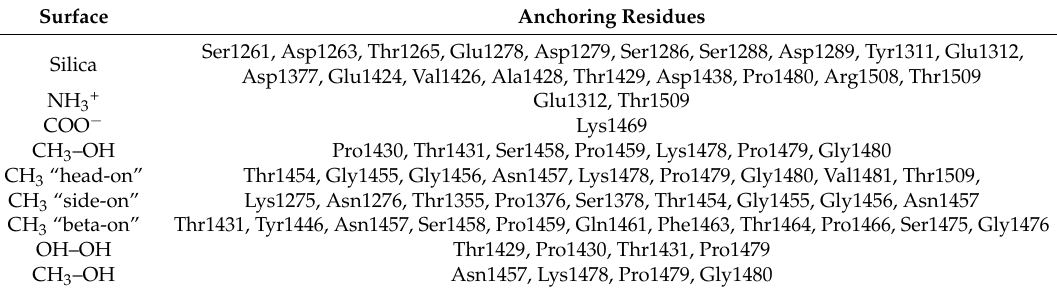
Table 1. Residues in contact with the surface at the final stage of adsorption.